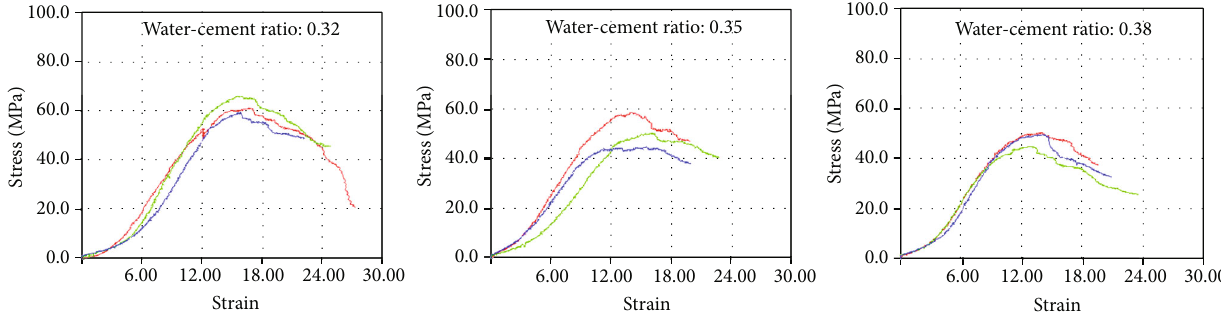
Figure 20: Uniaxial compressive stress-strain curve of new-type sealing cement.